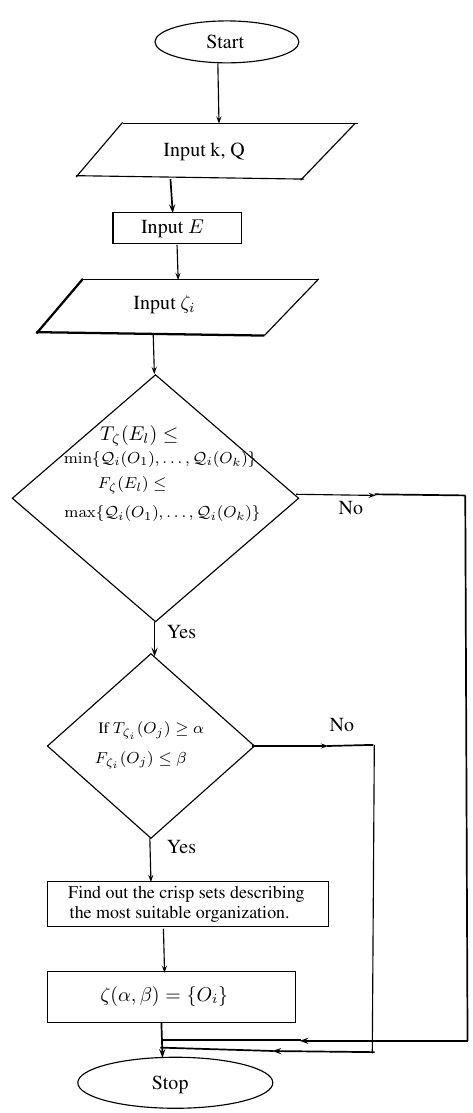
Figure 7. The flowchart of application.